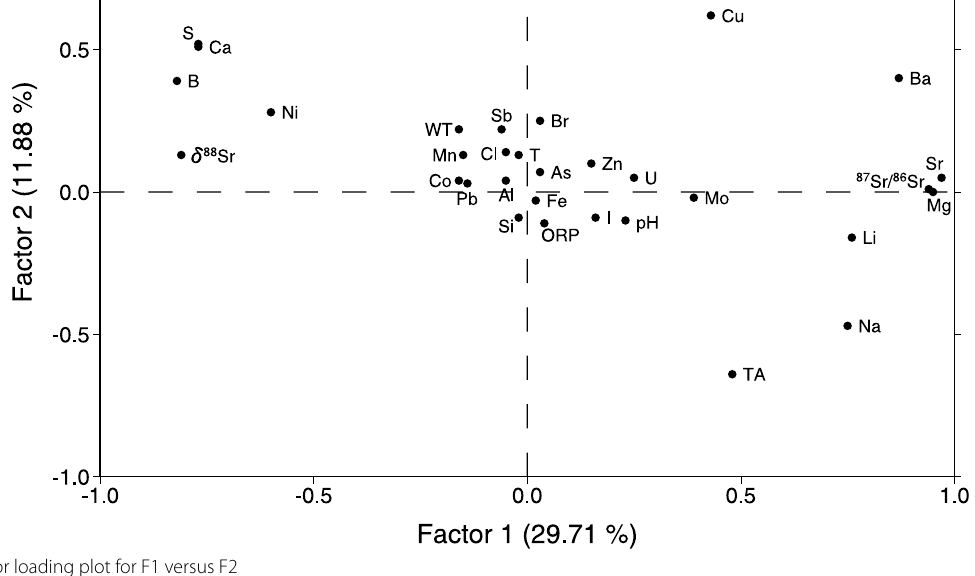
show positive scores and high score mud pools are dis- tributed in the north with great variation spatially and temporally (Figs. 5 and 7). By comparing mud pools